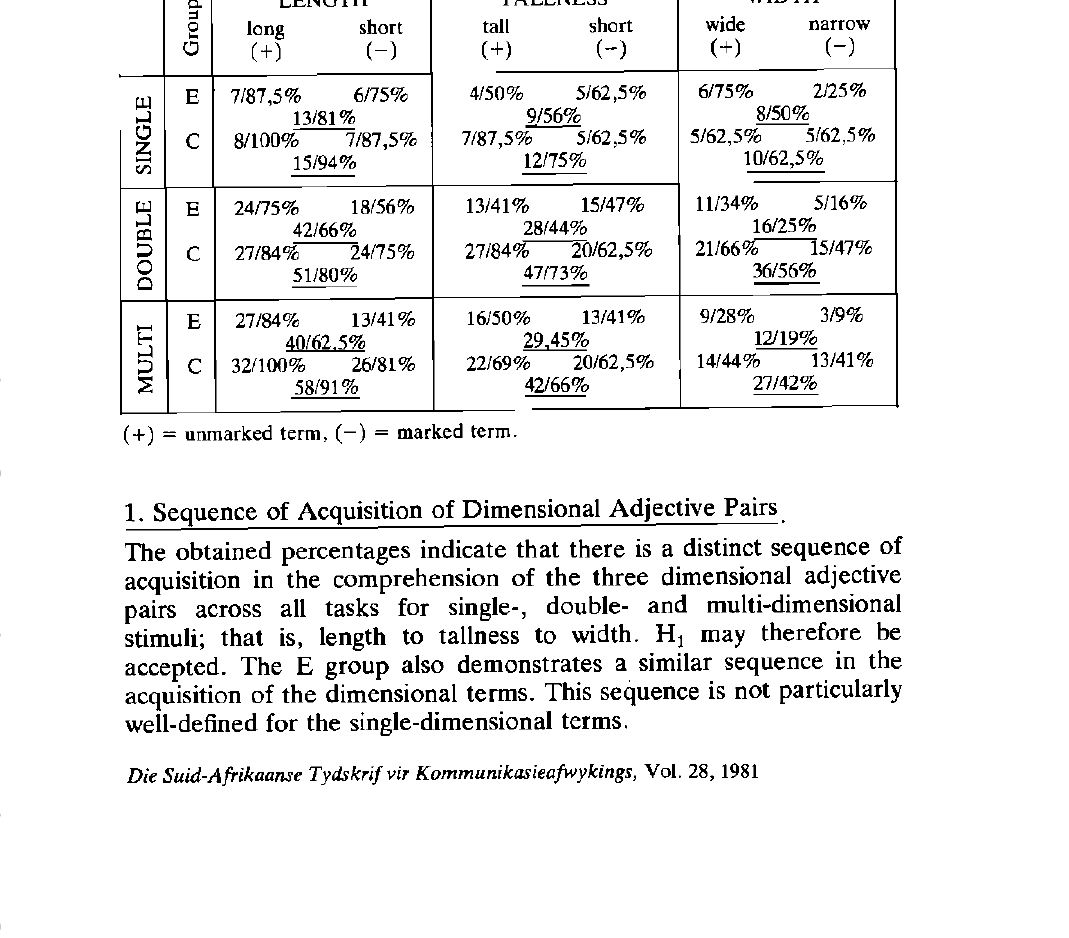
TABLE III: Number and percentag^of Correct Responses obtained by Ε and C Subjects